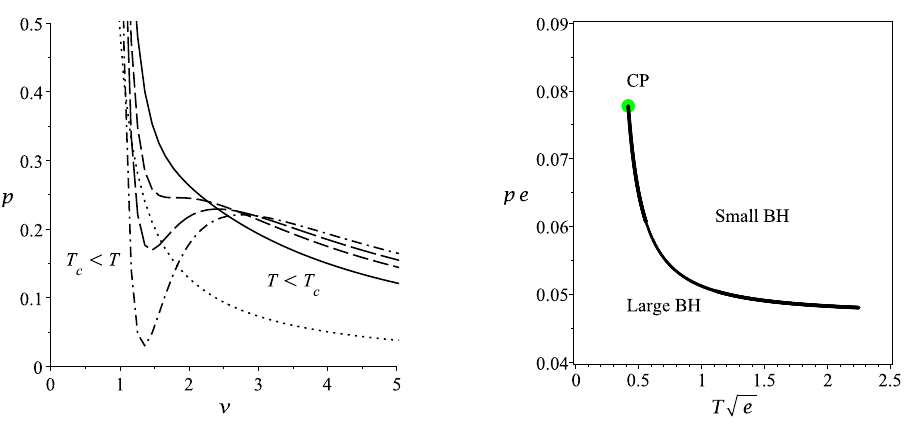
Figure 9 . Reverse Van der Waals phase transition in d = 5 ; k = (cid:0) 1 (color online). We choose e 2 = 1 = 10, (cid:12) 3 = (cid:0) 4 e 2 and (cid:11) 4 = (cid:0) 6 e 3 . Dimensionless critical quantities are T c and P c e (cid:25) 0 : 07772. Left: the behaviour of pressure versus volume for d = 5 and k = (cid:0) 1 for temperatures at critical point T = T c (dashed black line), T (cid:25) 0 : 8 T c (solid black line), T = 0 : 2 T c (dotted black line), T = 1 : 1 T c (long dashed black line), T = 1 : 2 T c (dash-dotted blue line). Right: coexistence curves for (cid:12)ve dimensional k = (cid:0) 1 charged black holes is depicted, with reverse VdW behaviour. The critical points are denoted by the green